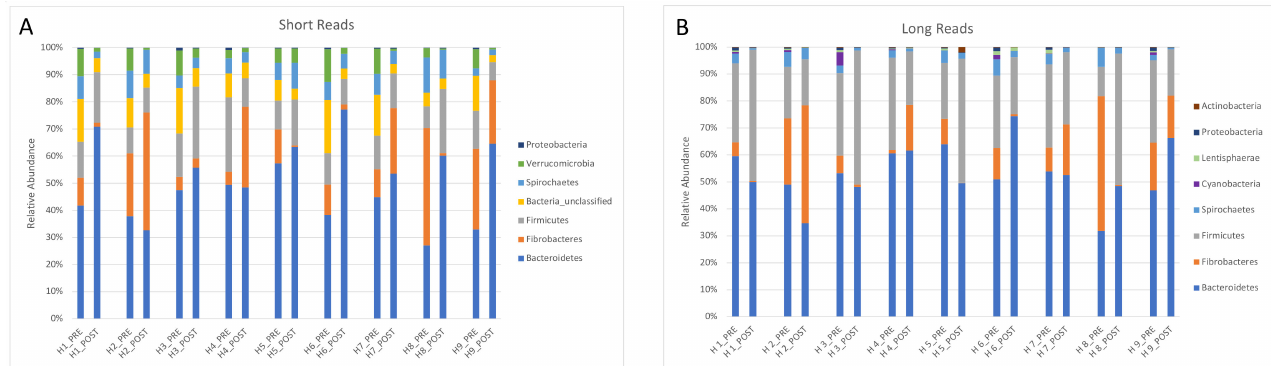
Figure 3. Relative abundance of the main phyla found in the feces of 9 horses investigated by Illumina short-read ( A ) and PacBio long-read sequencing ( B